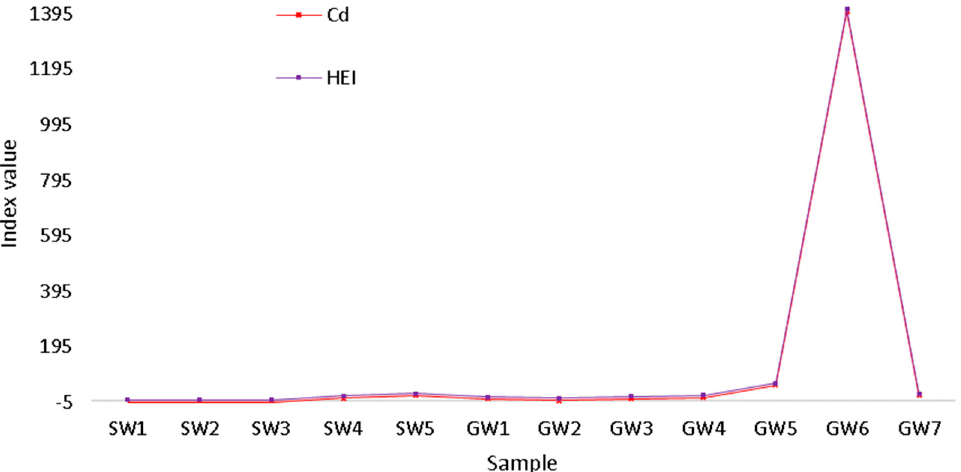
Figure 11. Cd and HEI of the samples studied.